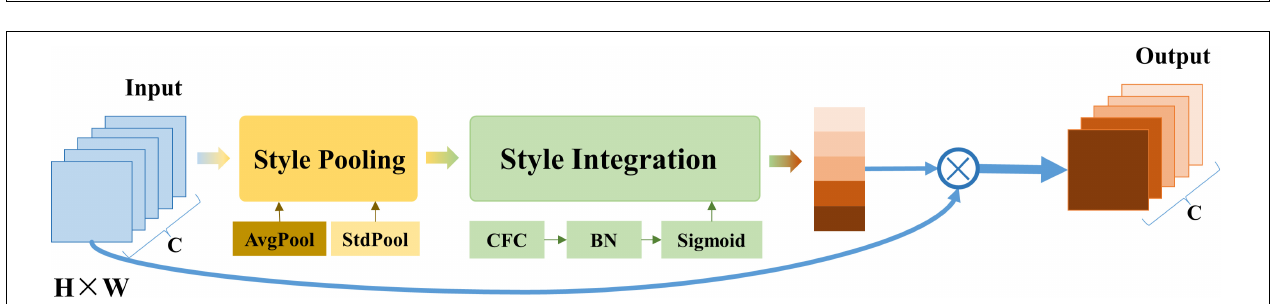
FIGURE 4 | The adjacent matrix of the information integration, decision process, and neuron response. The yellow block represents a connection between the corresponding electrodes, and the blue block represents no connection.